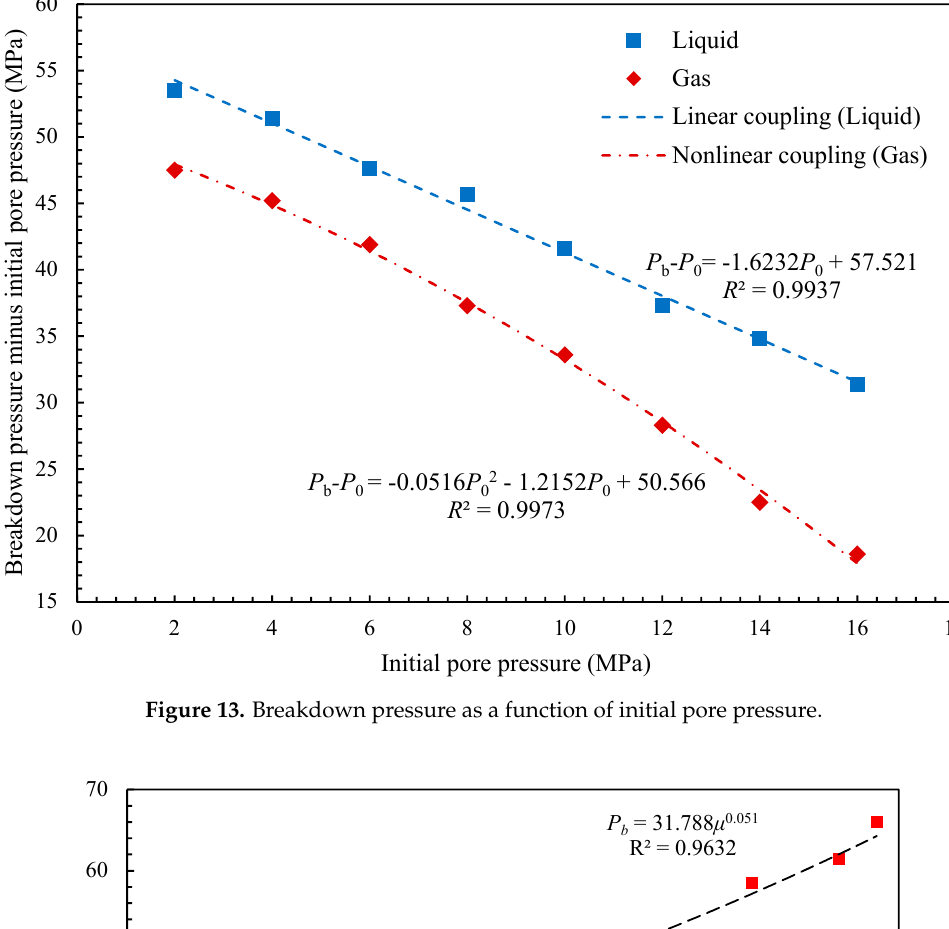
Figure 13. Breakdown pressure as a function of initial pore pressure.